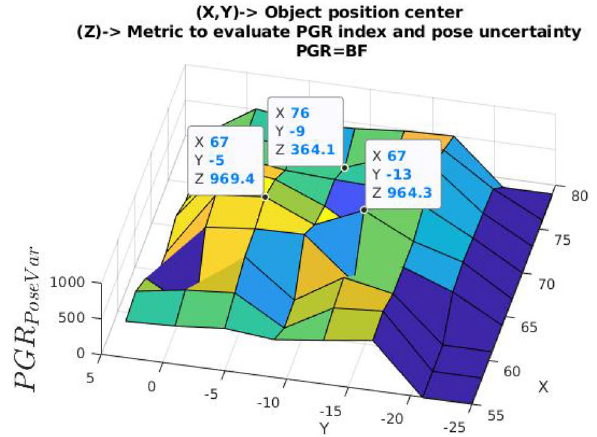
Fig. 10 PGR PoseVar index for each (X,Y) position of the